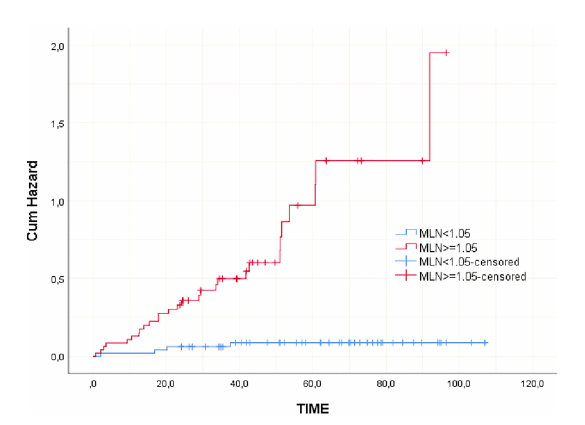
FIGURE 3 Graphs of cumulative hazard function for MLN categories.